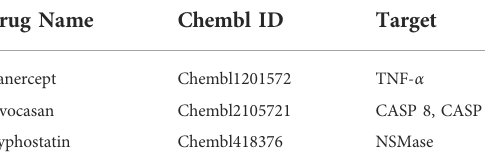
TABLE 2 Drugs for TNF- α mediated sphingomyelin signaling pathway from CHEMBL (https://www.ebi.ac.uk/chembl/). Drug Name